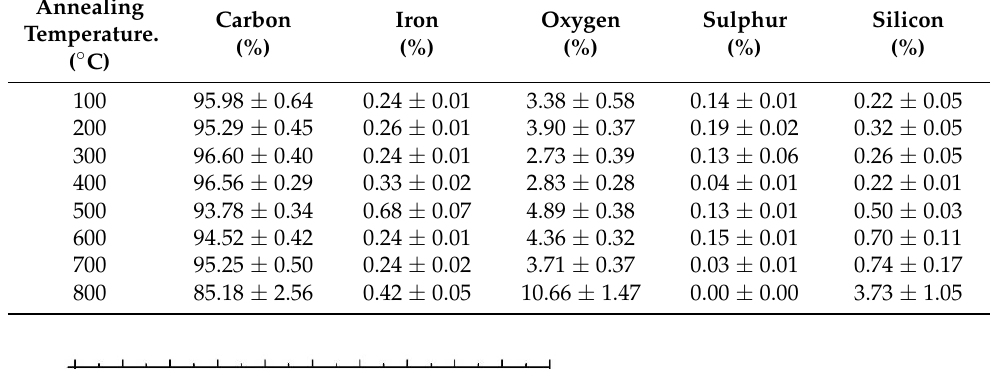
Table 1. Average elemental composition of CNT fibers annealed in tube furnace as measured by XPS. Annealing